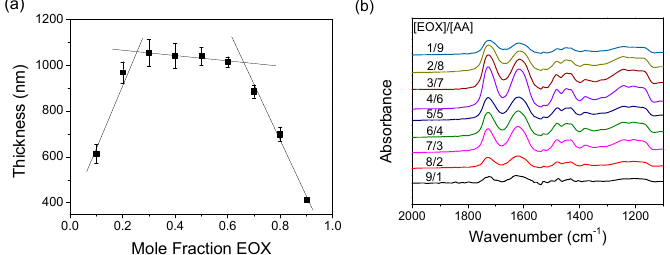
Figure 8. (PEOX/PAA) 20 prepared with different concentration ratio: ( a ) thickness of the film as a function of the concentration ratio (log([EOX]/[AA])); ( b ) FT-IR spectra of the films. ([EOX] + [AA] = 1.0 × 10 − 2 mol/L; PEOX, M w 500,000; PAA, M w 450,000; pH 2.0; assembling time, 4 min; rinsing time, 1 min; and room temperature).